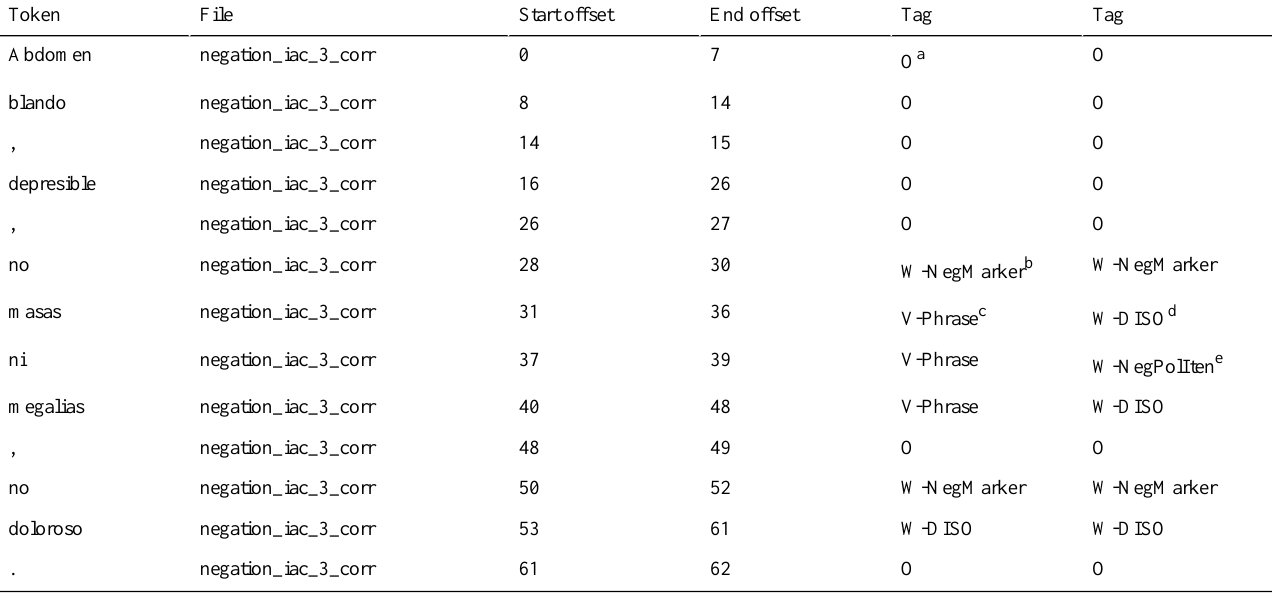
Table 4. Tokens annotated in the ConLL-2003 format.